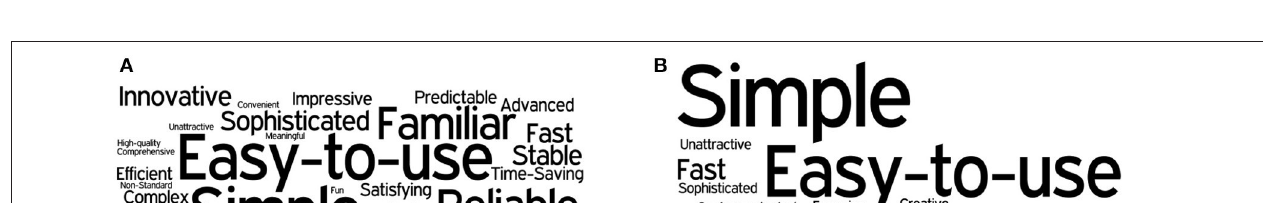
FIGURE 12 | Radial chart showing the user satisfaction surveys’ results summarized in different device features.